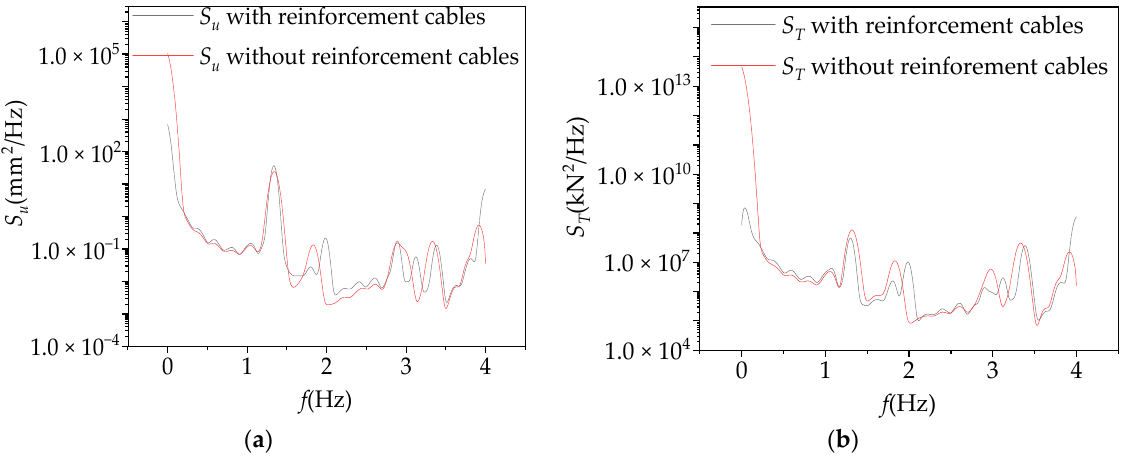
Figure 11. Analysis on the response spectrum of the analyzed cable with or without reinforcement cables: ( a ) bridge displacement response spectrum and ( b ) cable tension response spectrum.